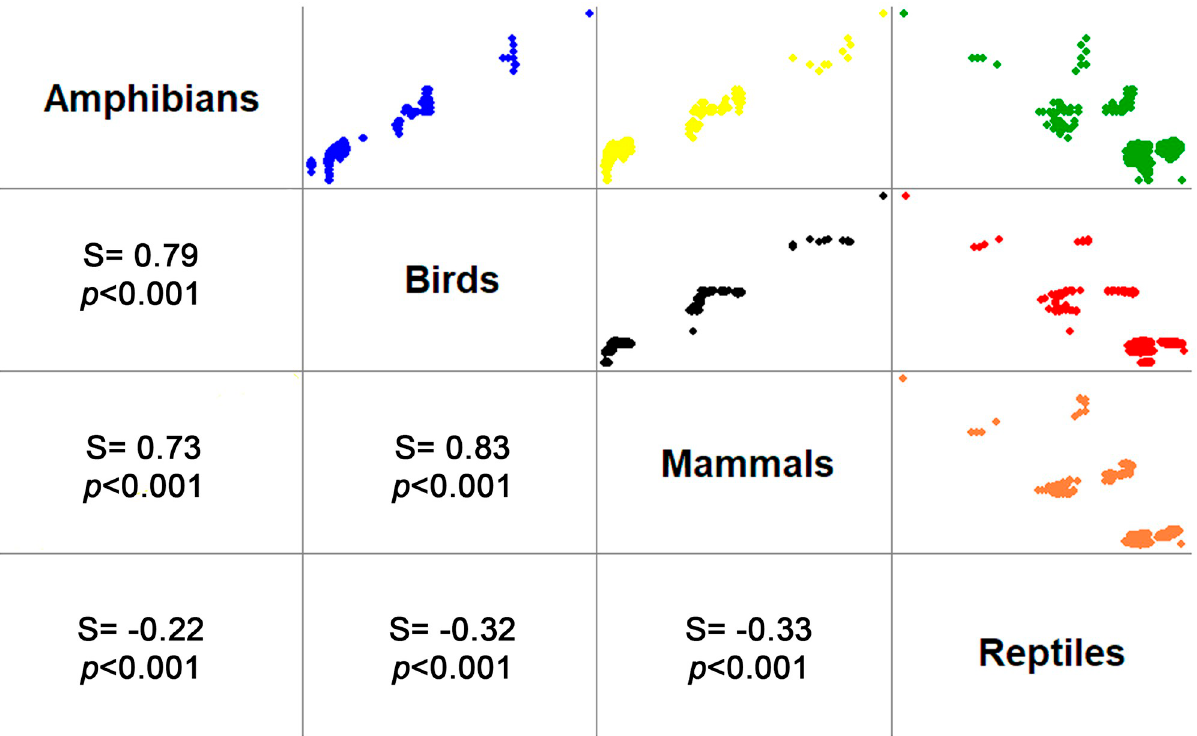
Fig 5. Spearman correlation coefficients (S) and p-value (under the diagonal) and scatterplot (over the diagonal) for crossed species richness among groups in Colima, Mexico. Note the high coincidence (trend) between richness values for all groups, and the opposite trend for reptiles in contrast to the other